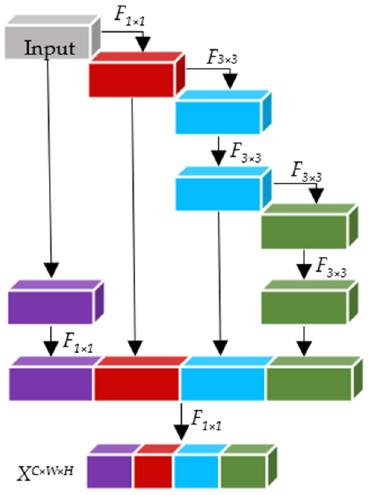
Figure 1. ELAN network structure.